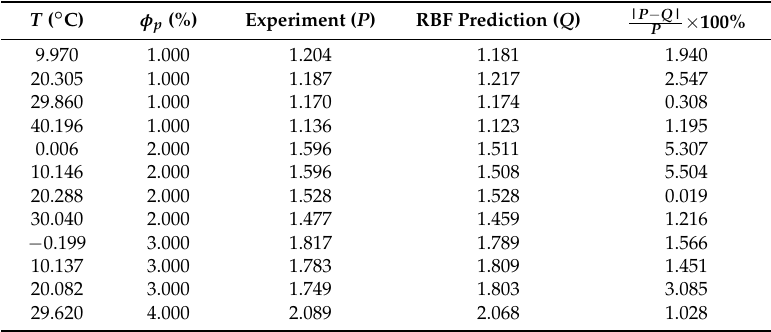
Table 7. Comparisons of the RBF predicted viscosity ratio of CuO-ethylene glycol/water (60:40 by weight ratio) nanofluids with the experimental data of Namburu et al.